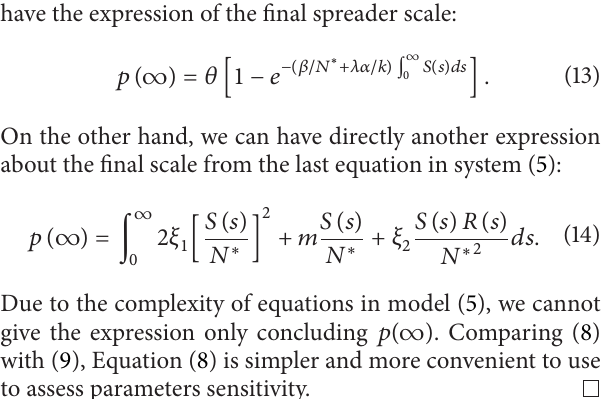
Substituting the relation 𝑝(∞) = 𝜃(𝑁 ∗ − 𝐼(∞))/𝑁 ∗ , we